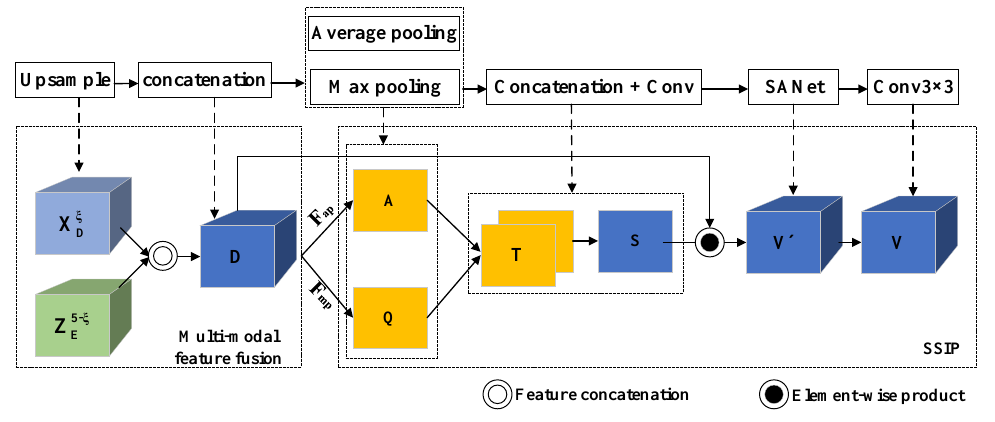
Figure 3. Decoder with multimodal feature fusion and